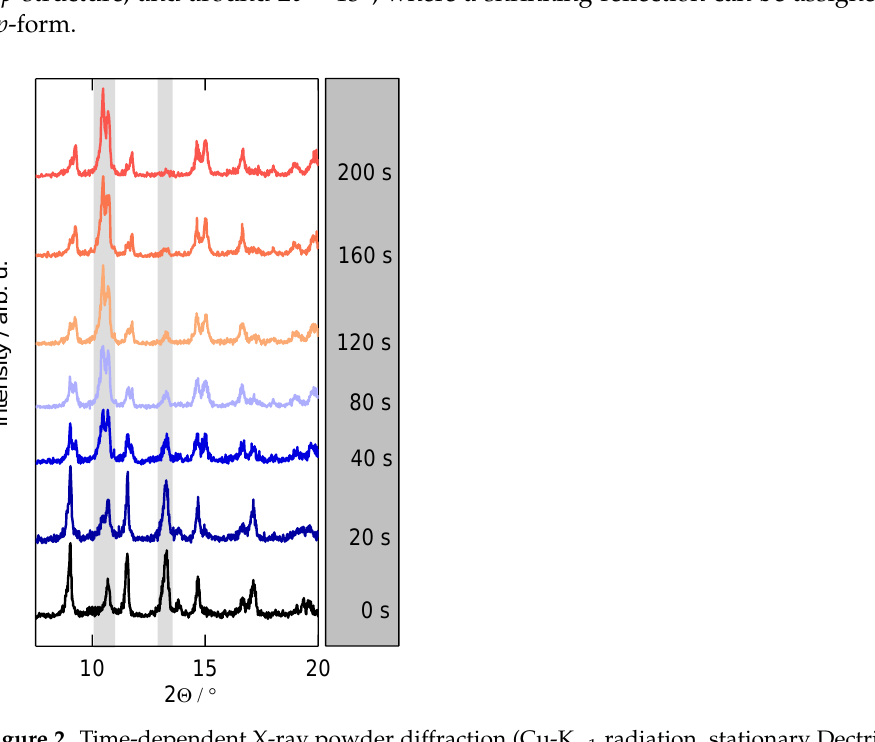
Figure 2. Time-dependent X-ray powder diffraction (Cu-K α 1 radiation, stationary Dectris Pilatus detector) patterns for the uptake of n -butane on 1 at 298 K for a pressure step of 0 → 10 kPa in a glass capillary. The grey bars emphasize the two areas (2 θ ≈ 11° and 13°) with the most significant change regarding the phase transition.